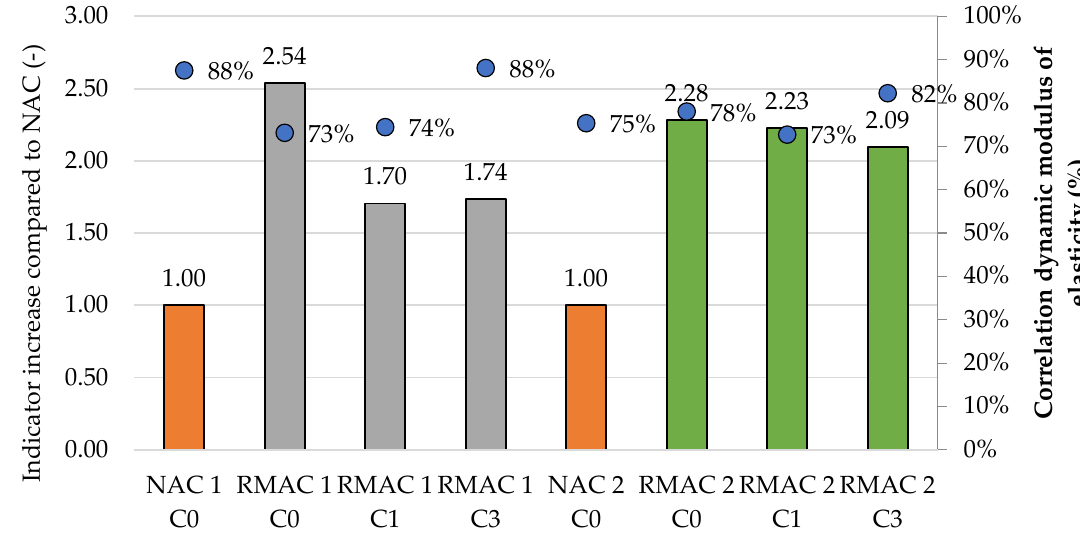
Figure 9. Carbonation resistance—the indicator increases of measured carbonation depth compared to NAC and correlation of dynamic modulus of elasticity of NAC and RMAC samples no exposed to CO 2 and exposed to CO 2 .